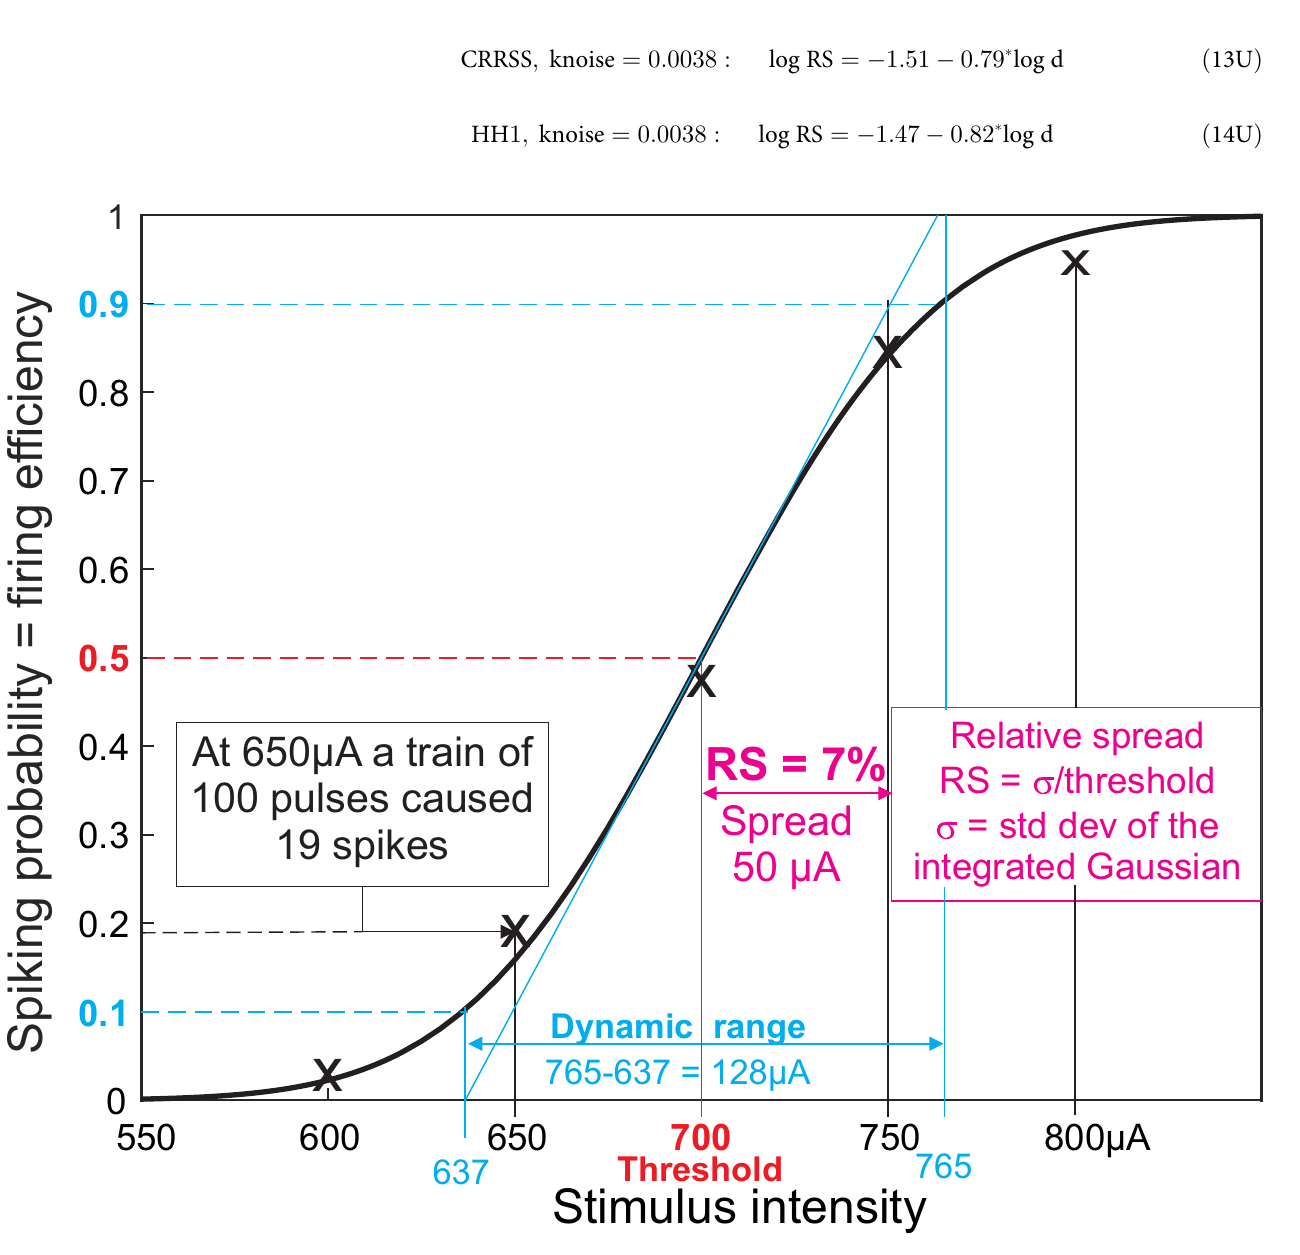
Fig 3. Relationship between firing efficiency, relative spread (RS) and dynamic range (cyan). The spread is plotted in magenta. The black curve is the Gaussian fit for five spiking probabilities (marked with x) with intensities 600, 650, 700, 750 and 800 μ A. 700 μ A represents the threshold value, i.e. the one in which a spike occurs in 50% of the stimulus trials. The dynamic range (normalized to threshold) corresponds to 2.56 times